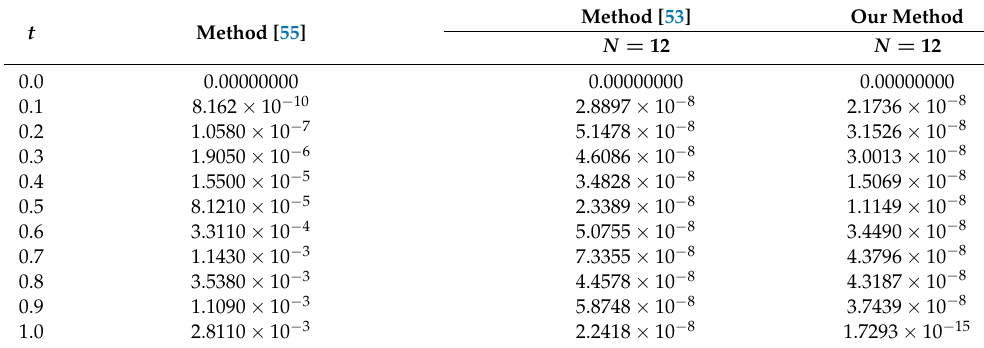
Table 5. Comparison of the absolute errors obtained using the MLG method for ν = 1, in Example 4, to the absolute errors obtained using the methods in [53,55]: